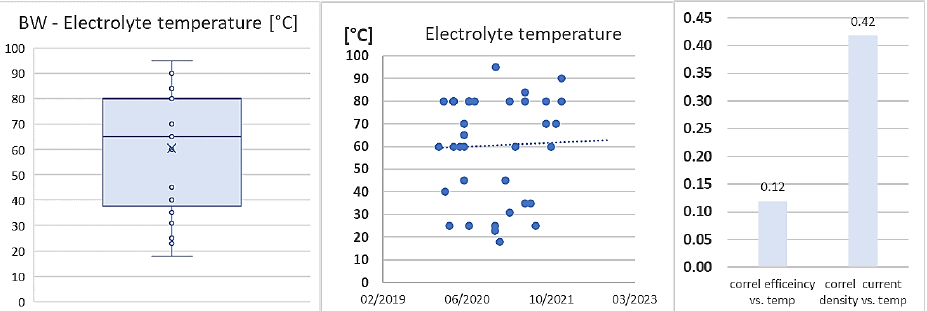
Figure 8. Graphic representation of the electrolyte temperature [12,47,57,59,62,83,85,89,90,93,98,101,103,105,108,113 – 115,117,120,122 – 125,129,131,134,137 – 140,142 – 144,146].